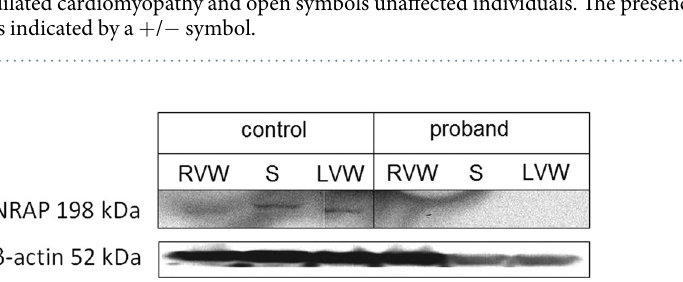
Figure 2. Western blot of NRAP protein from heart samples of proband and control. RVW - right ventricular wall, S - septum, LVW - left ventricular wall. Control sample was taken from heart transplantation recipient without truncating variants in NRAP